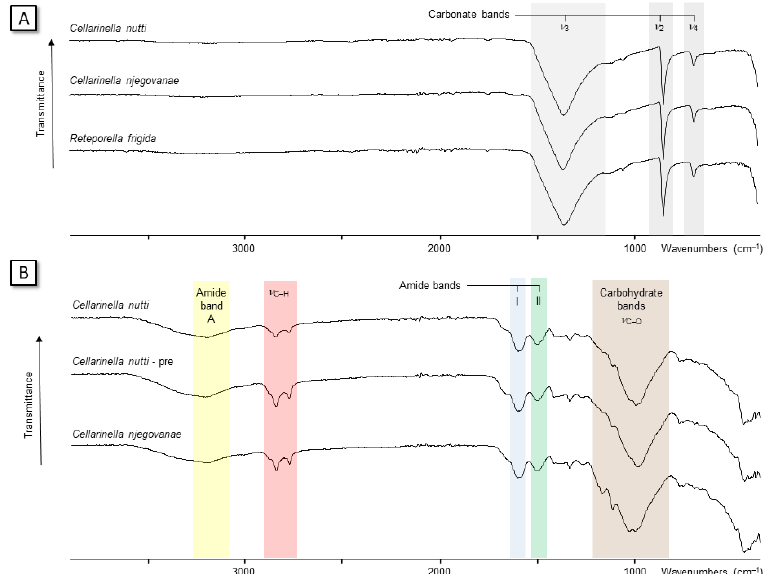
Figure 9. FT-IR spectra: ( A ) clean skeletal powder of Cellarinella nutti, Cellarinella njegovanae and Reteporella frigida ; ( B ) acid Insoluble Matrix (AIM) of C. nutti, C. nutti PRE and C. njegovanae. PRE = pre-bleached. The absorption bands corresponding to identified functions are highlighted in color.